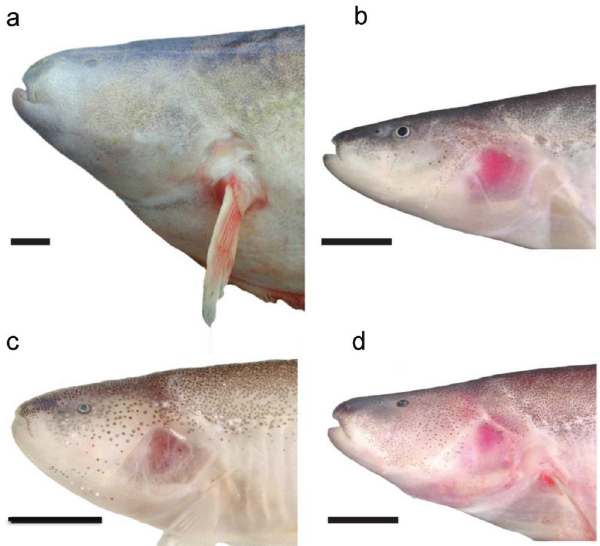
Fig. 12. Photographs heads of live specimens of four syntopic species of Sternarchella from the vicinity of Tefé, Amazonas, Brazil. a. Sternarchella rex holotype (MCP 49422). b. Sternarchella schotti (MCP 49429. c. Sternarchella calhamazon (MCP 49420. d. Sternarchella orthos (MCP 49436). Scale bar = 10 mm. The flanks of this fish were considerably paler moments before this photograph was